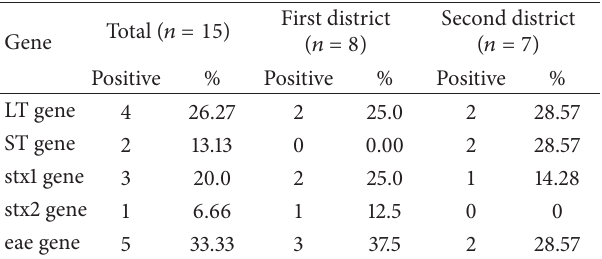
Table 4: Virulence genes among E. coli isolates in both